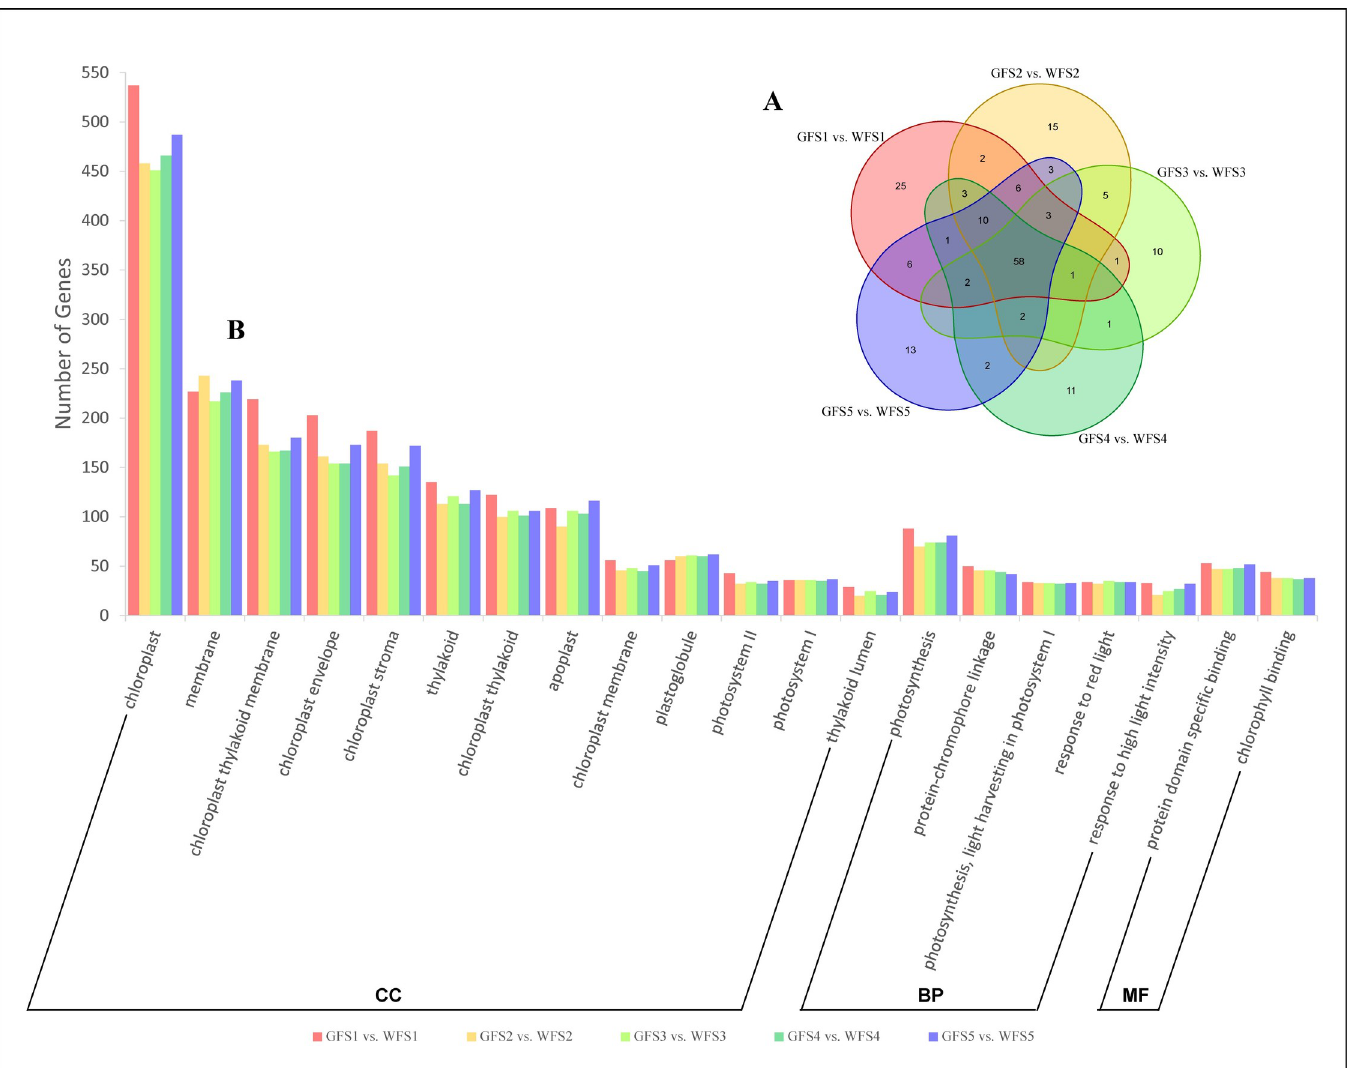
Fig 6. Gene Ontology (GO) enrichment analysis of annotated DEGs between the GF and WF across five developmental stages. A , Venn chart showing the overlap in GO enrichment terms at five stages. The number in the cycle indicating the number of terms. B , Twenty common GO terms enriched at all five stages. CC, cellular components; BP, biological process; MF, molecular